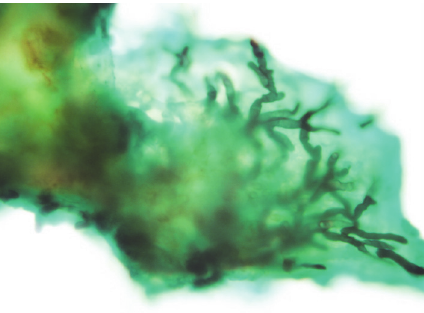
Figure 3: Grocott’s methenamine silver stain of a piece of pseudom- embrane obtained during bronchoalveolar lavage showed dichoto- mously branched and septate hyphae, suggestive of the diagnosis of Aspergillus . 400-fold magnification.